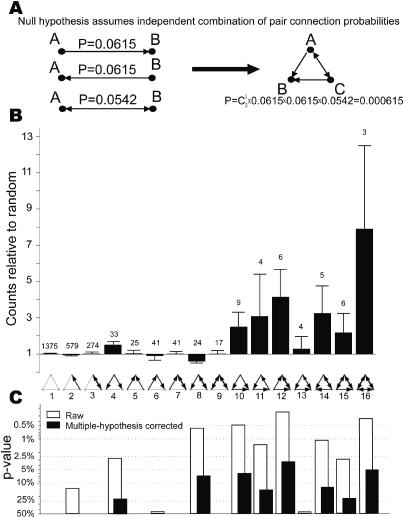
Several Three-Neuron Patterns Are Overrepresented as Compared to the Random Network(A) Null hypothesis for three-neuron patterns assumes independent combinations of connection probabilities of two kinds of two-neuron patterns.(B) Ratio of actual counts (numbers above bars) to that predicted by the null hypothesis. Error bars are standard deviations estimated by bootstrap method.(C) Raw (open bars) and multiple-hypothesis testing corrected (filled bars) p-values. p-values above 0.5 are not shown.